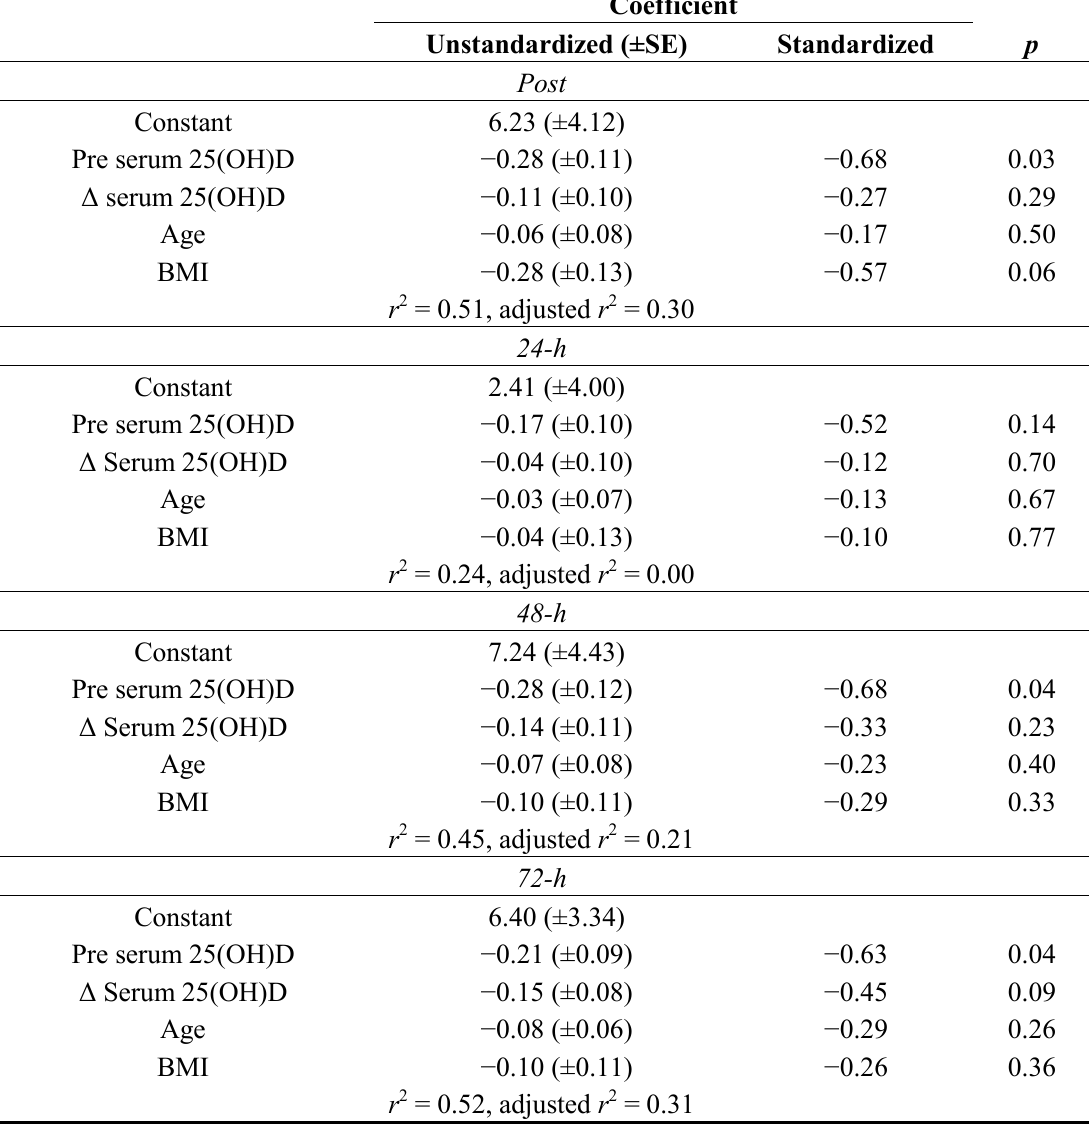
Table 1. Higher serum 25(OH)D concentrations predict a lower deficit 1 in muscle strength immediately ( i.e. , Post) and days ( i.e. , 48-h and 72-h) after intense